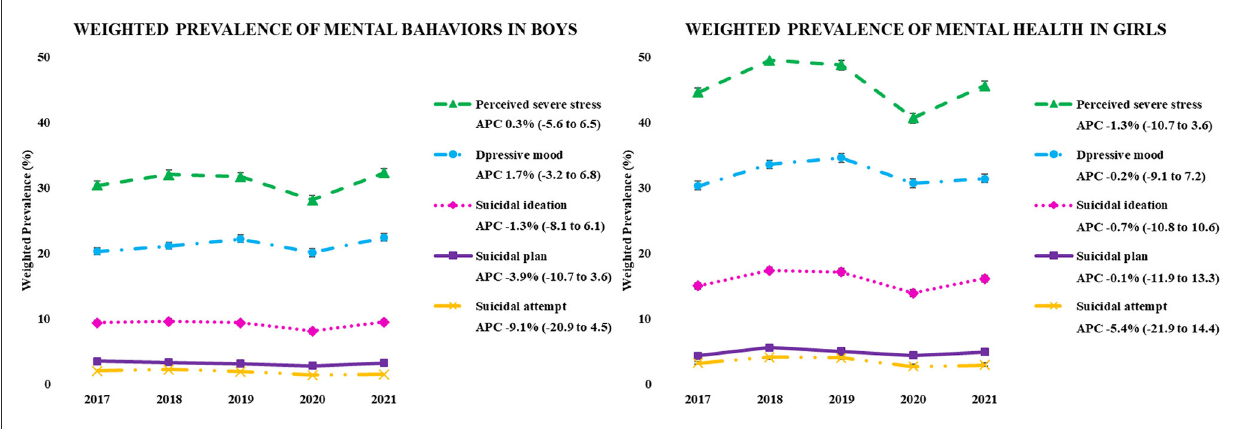
FIGURE2 The weighted prevalence of mental health in the KYRBS 2017–2021